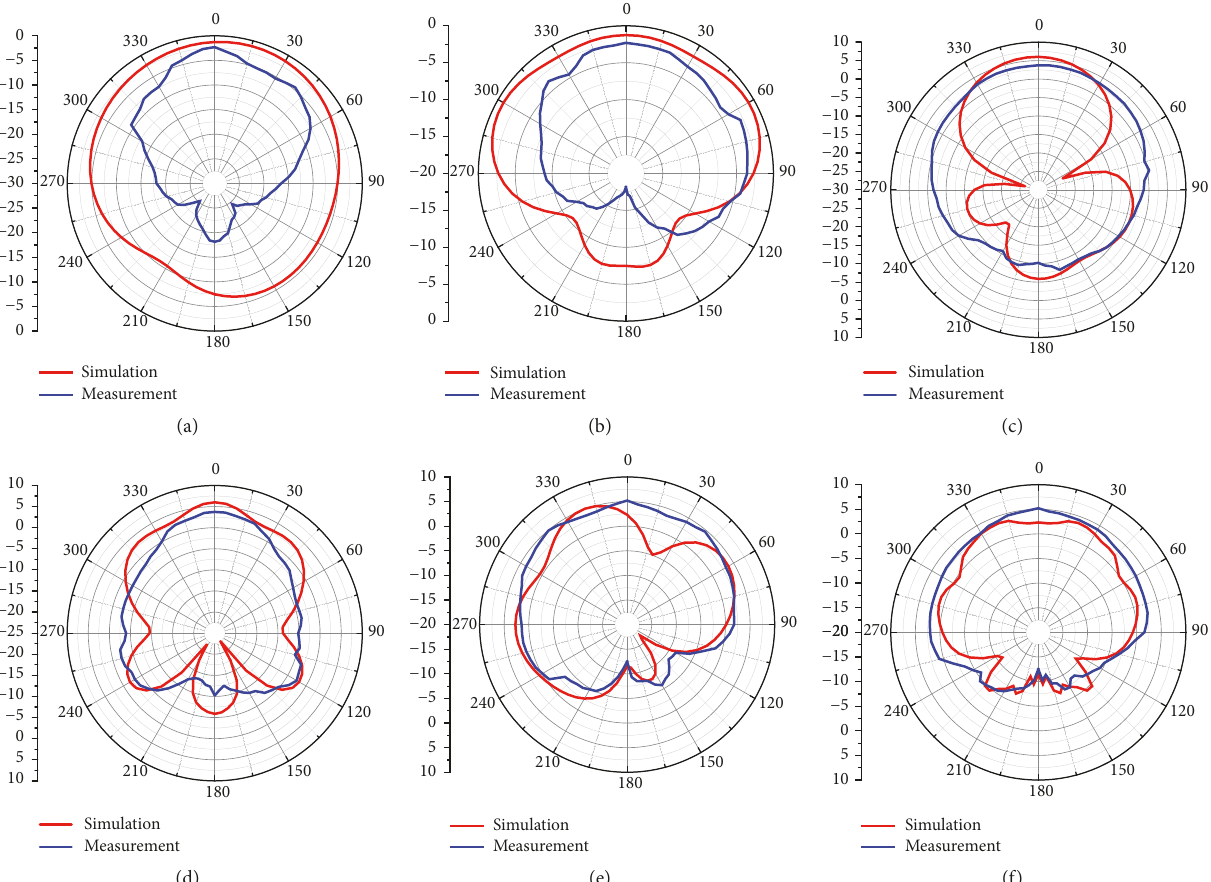
Figure 15: Comparison of radiation patterns between measurement and simulation. (a) E-plane at 6 GHz. (b) H-plane at 6 GHz. (c) E-plane at 11GHz. (d) H-plane at 11GHz. (e) E-plane at 16 GHz. (f) H-plane at 16